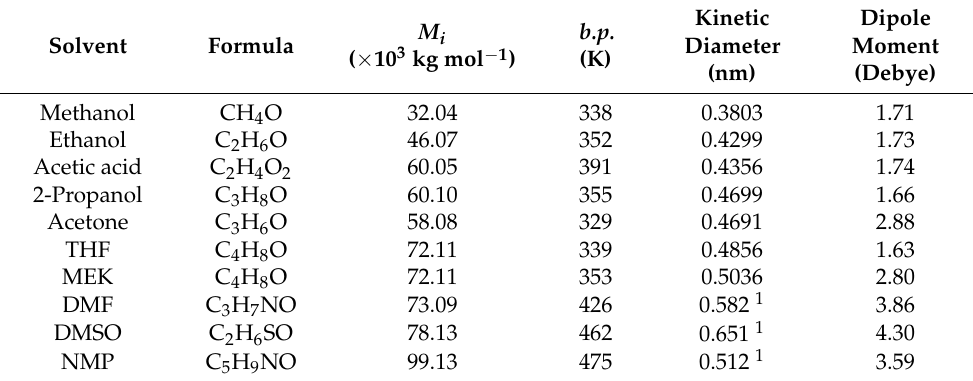
Table 3. Chemical properties of organic solvents